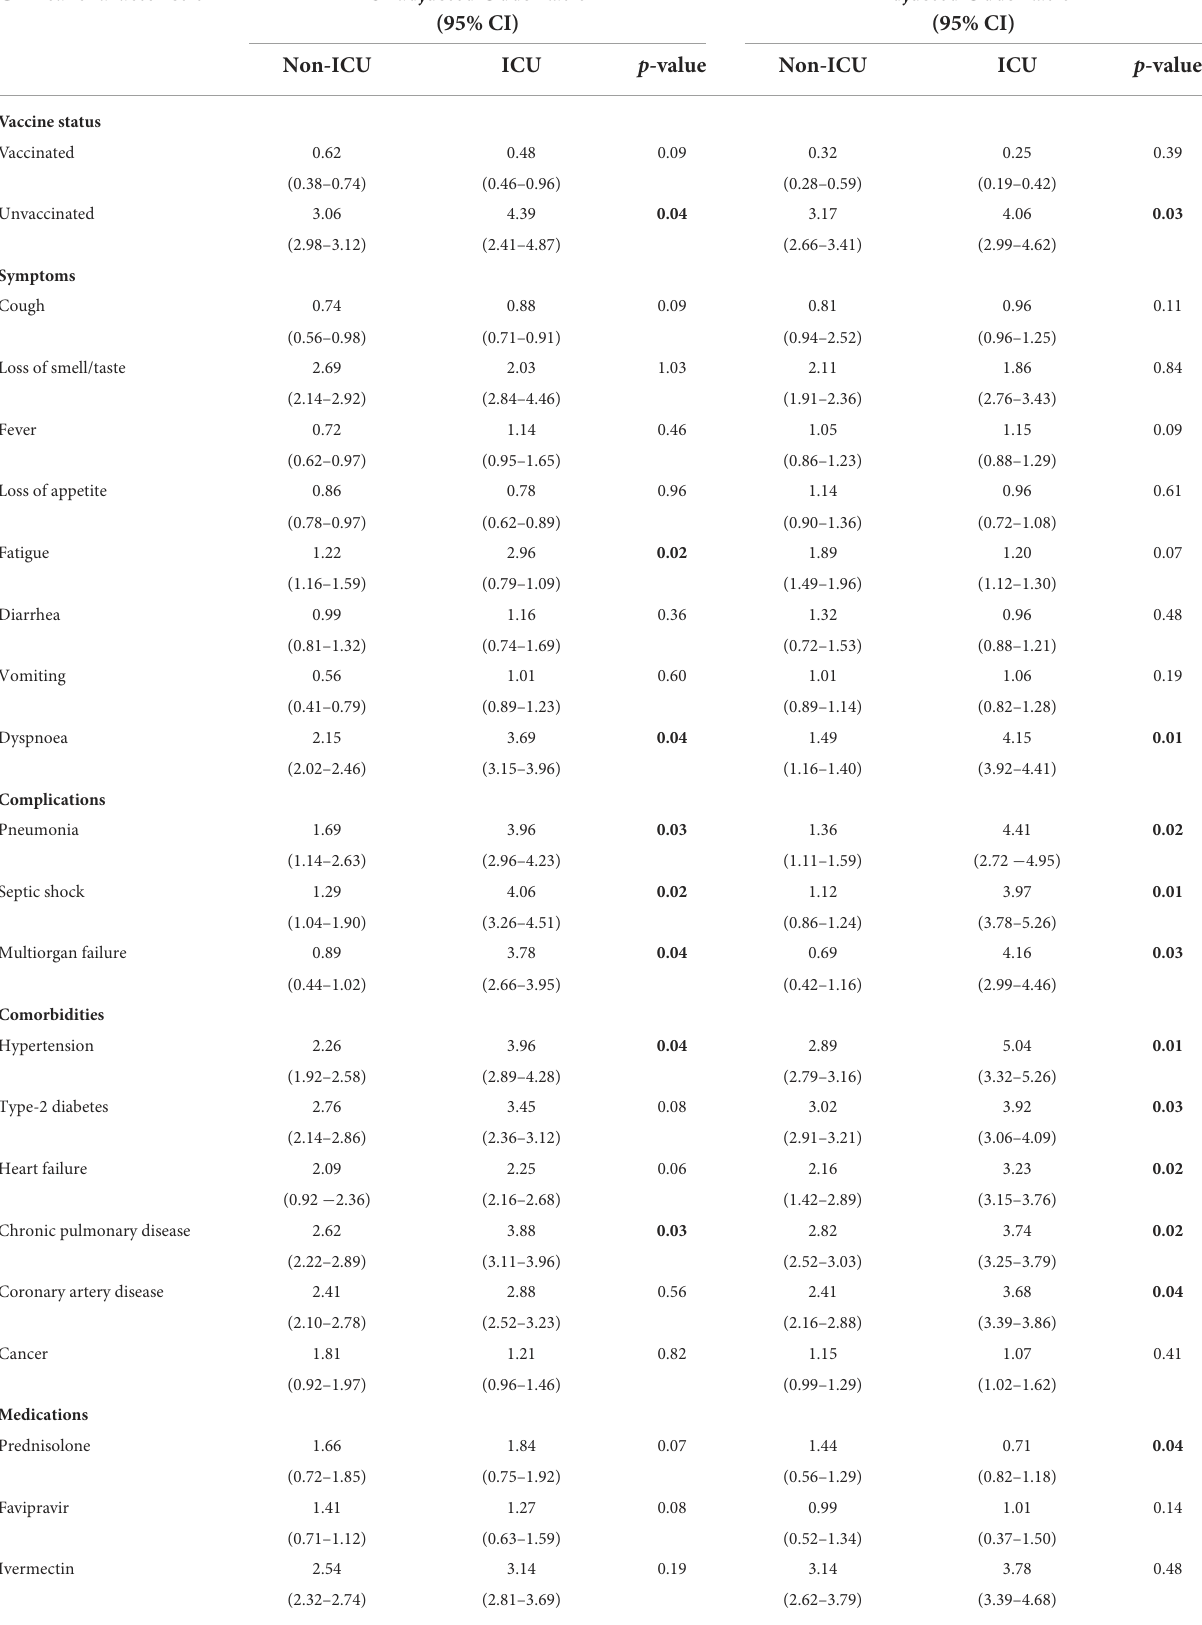
TABLE 4 Association between potential risk factors and COVID-19 hospitalization depending on clinical